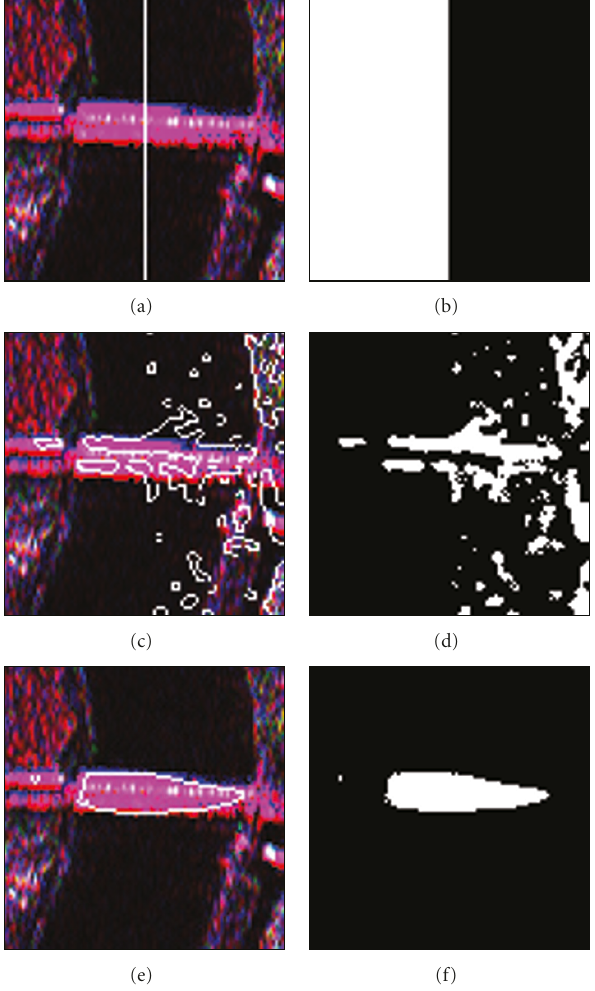
Figure 5: Segmentation result on a PiSAR image, size: 102 × 96, α = 3, μ = 113. Left column: PolSAR image and the contours. Right column: corresponding object segmentation results. (a) and (b) Initial; (c) and (d): after 30 iterations; (e) and (f) converged state after 290